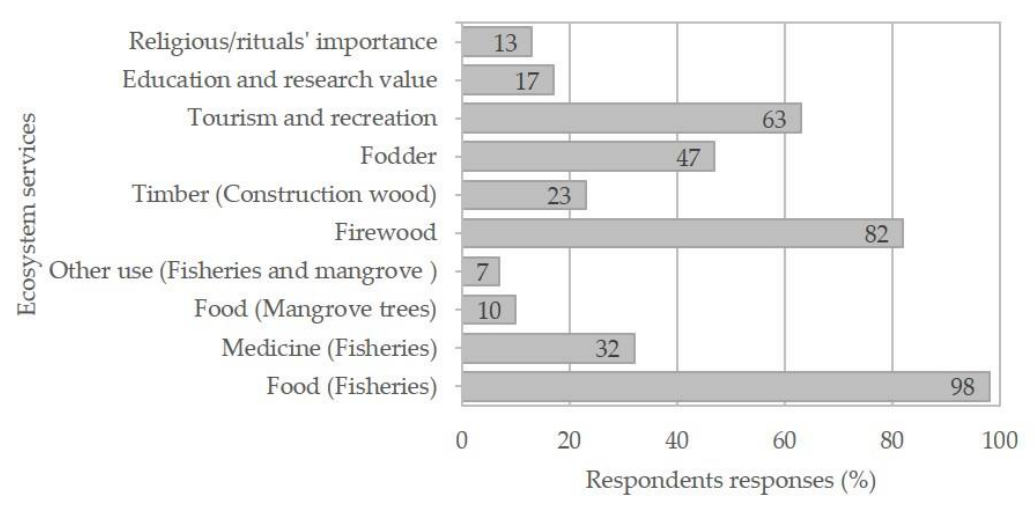
Figure 2. Ecosystem services derived from the coastal and mangrove ecosystems on the south-eastern coast of Bangladesh (respondents perceived to benefit from individual or community levels).